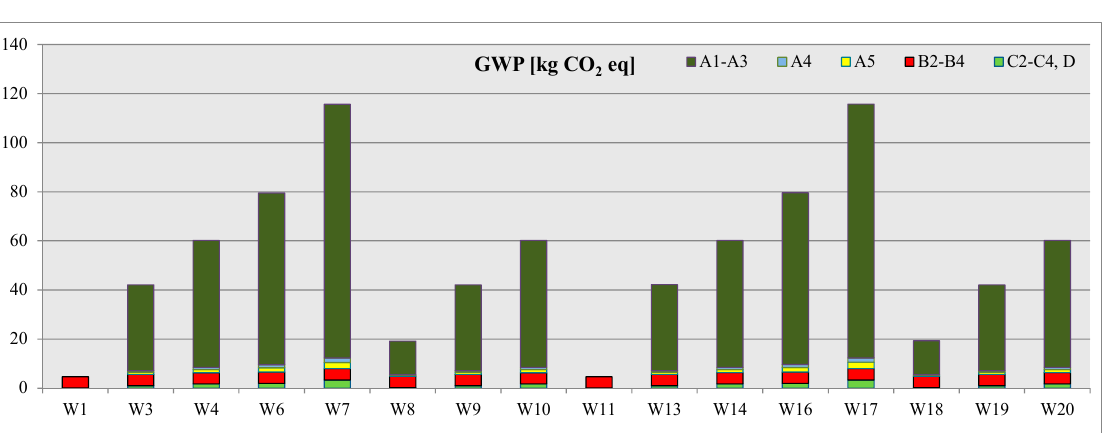
Figure 3. C2C Global Warming Potential (GWP, in kg CO 2 eq, with the energy needed for heating and cooling not being considered) of each alternative of external wall.